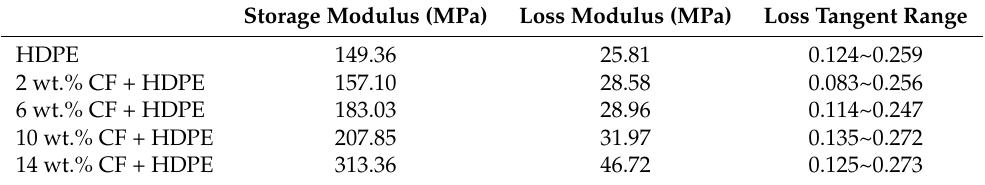
Figure 9. Effects of CFs on loss tangent ( tan δ ). Table 4. A summary of dynamic mechanical